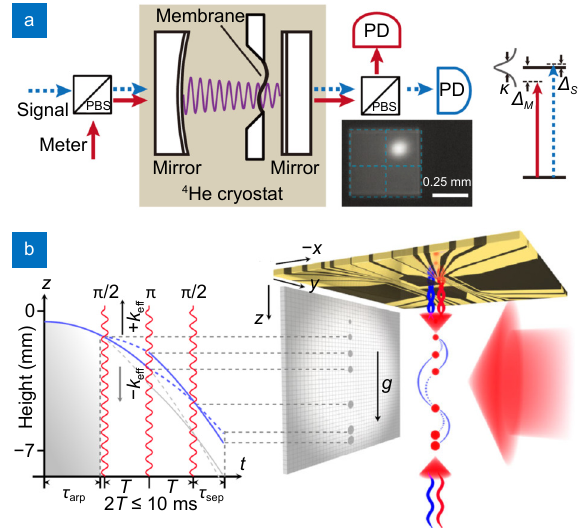
Fig. 30 | ( a ) Experimental setup of the ultra-sensitive optomechanic- al system proposed. ( b ) An atom-chip based accelerometer setup and space-time trajectories. Figure reproduced with permission from: (a) ref. 168 , The American Association for the Advancement of Sci- ence; (b) ref. 169 , America Physical